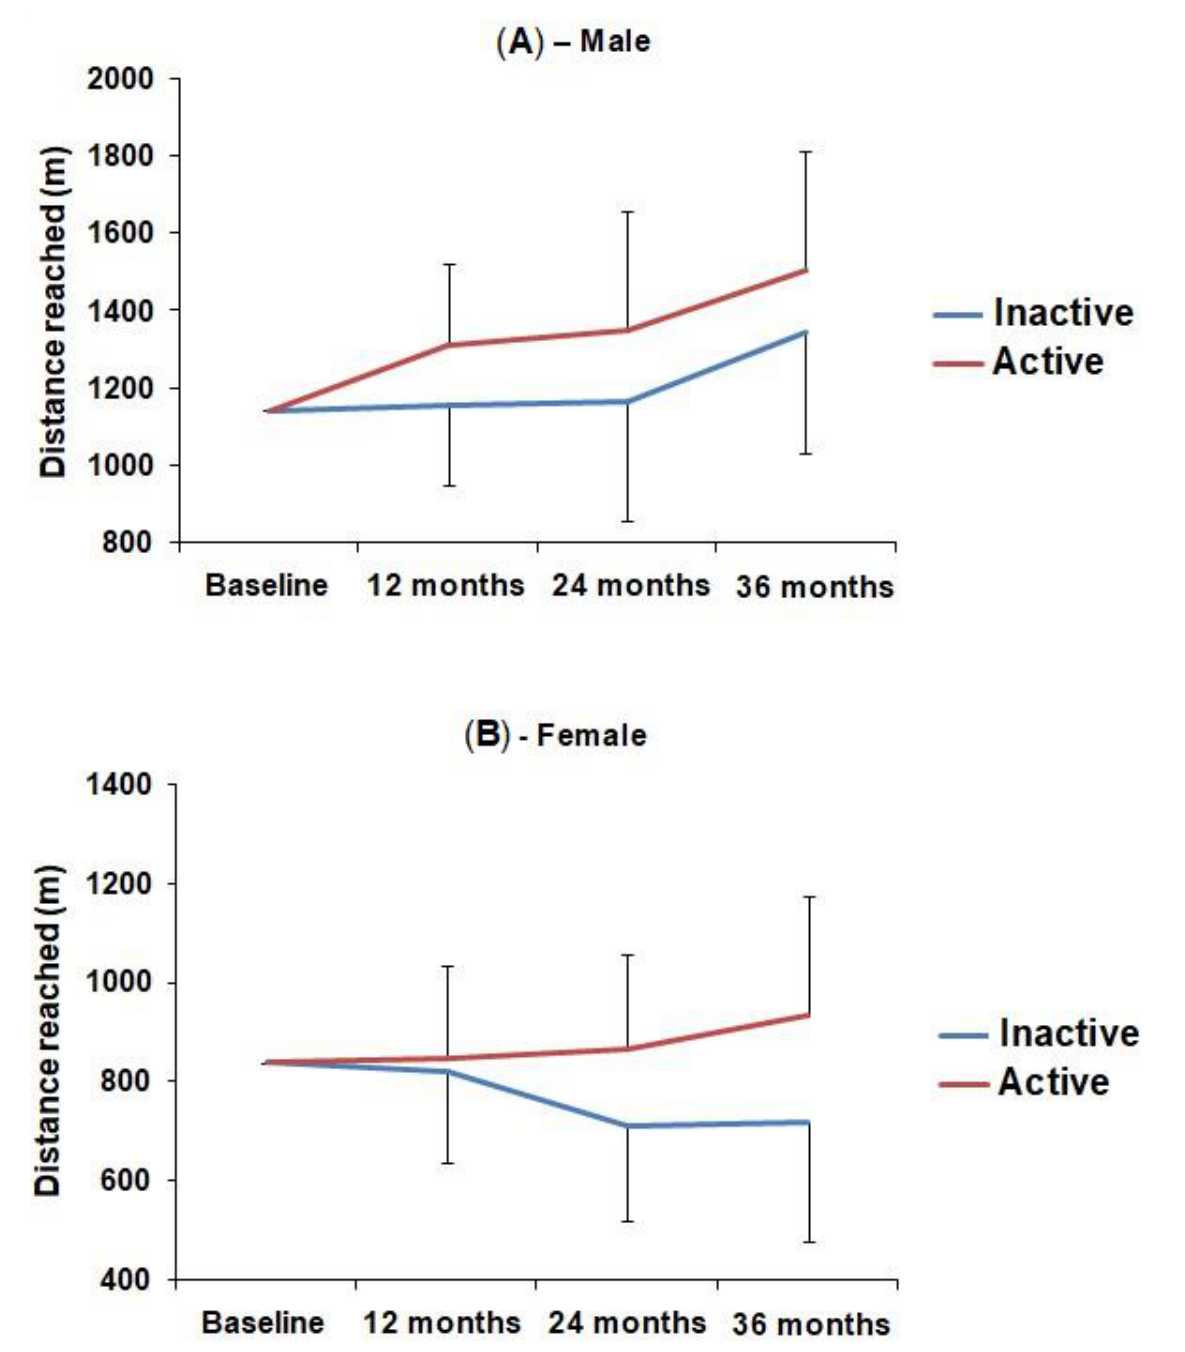
Figure 2. Mean and standard deviation of distance covered in the aerobic fitness test by males ( A ) and females ( B ) according to the level of physical activity over the 36-month study period. The trend analysis revealed a linear behavior of the interaction between physical activity and changes in aerobic fitness over 36 months, both in males (Distance covered: F1.78 = 4.567; p = 0.04; VO 2max : F1.78 = 5.323; p = 0.02) and females (Distance covered: F1.41 = 6.989; p = 0.01; VO 2max : F1.41 = 6.585; p = 0.01). In males, the analysis of stability or tracking of the distance covered in the test suggests that the maintenance of the relative position of each subject within the group over time is lower in the physically active group when compared to the less active group (0.47 (95% CI = 0.29–0.64) vs. 0.75 (95% CI = 0.65–0.84), respectively). In females, stability of aerobic performance was similar between active and less active groups (0.66 (95% CI = 0.40–0.87) vs. 0.64 (95% CI = 0.48–0.78), respectively) (data not shown in